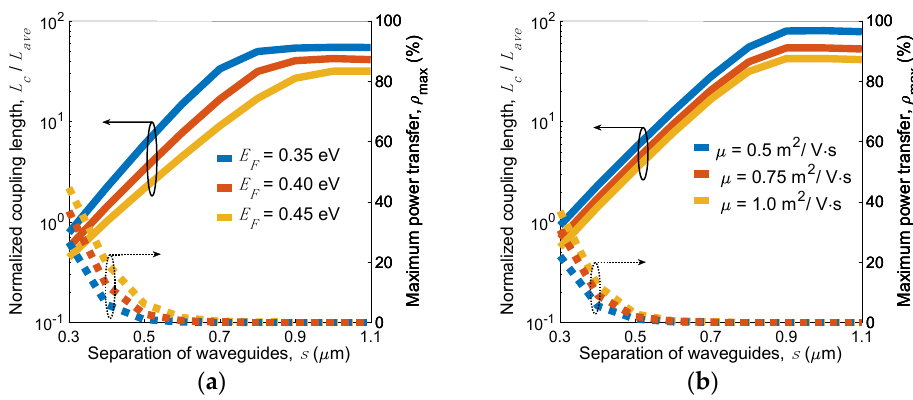
Figure 14. Normalized coupling length, L c / L ave and maximum transfer power, ρ max as functions of separation of waveguides, s for several values of ( a ) E F at µ = 1 m 2 /V·s and ( b ) µ at E F = 0.4 eV for f = 30 THz and the geometry parameters w g = 180 nm, w r = 20 nm, h r = 30 nm, t Si = 25 nm, and t d = 25 nm.